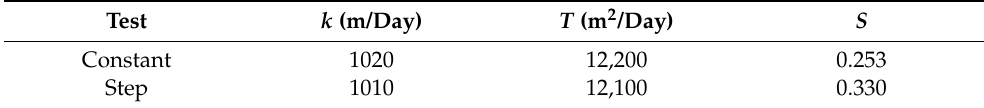
Table 3. Aquifer parameters obtained at well Z-1.